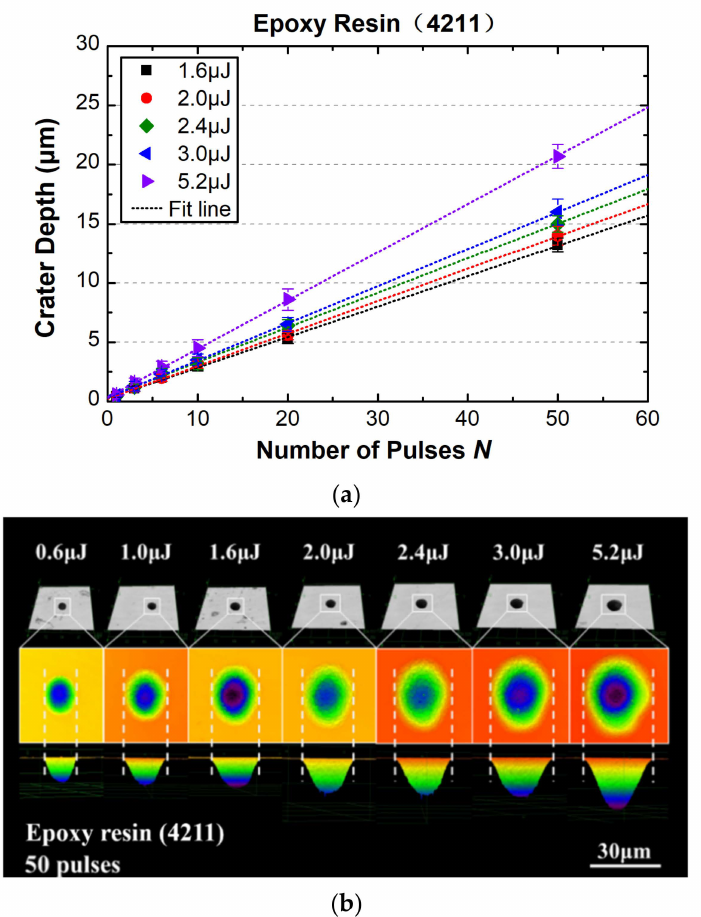
Figure 4. ( a ) Ablation rate with increased pulse number at different pulse energies; ( b ) typical morphologies for 50-pulse ablation of the 4211 resin at different excitations.